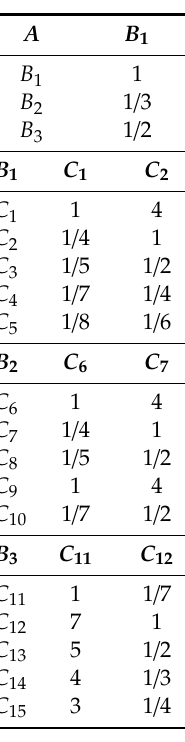
Table 2. Scoring table with AHP.